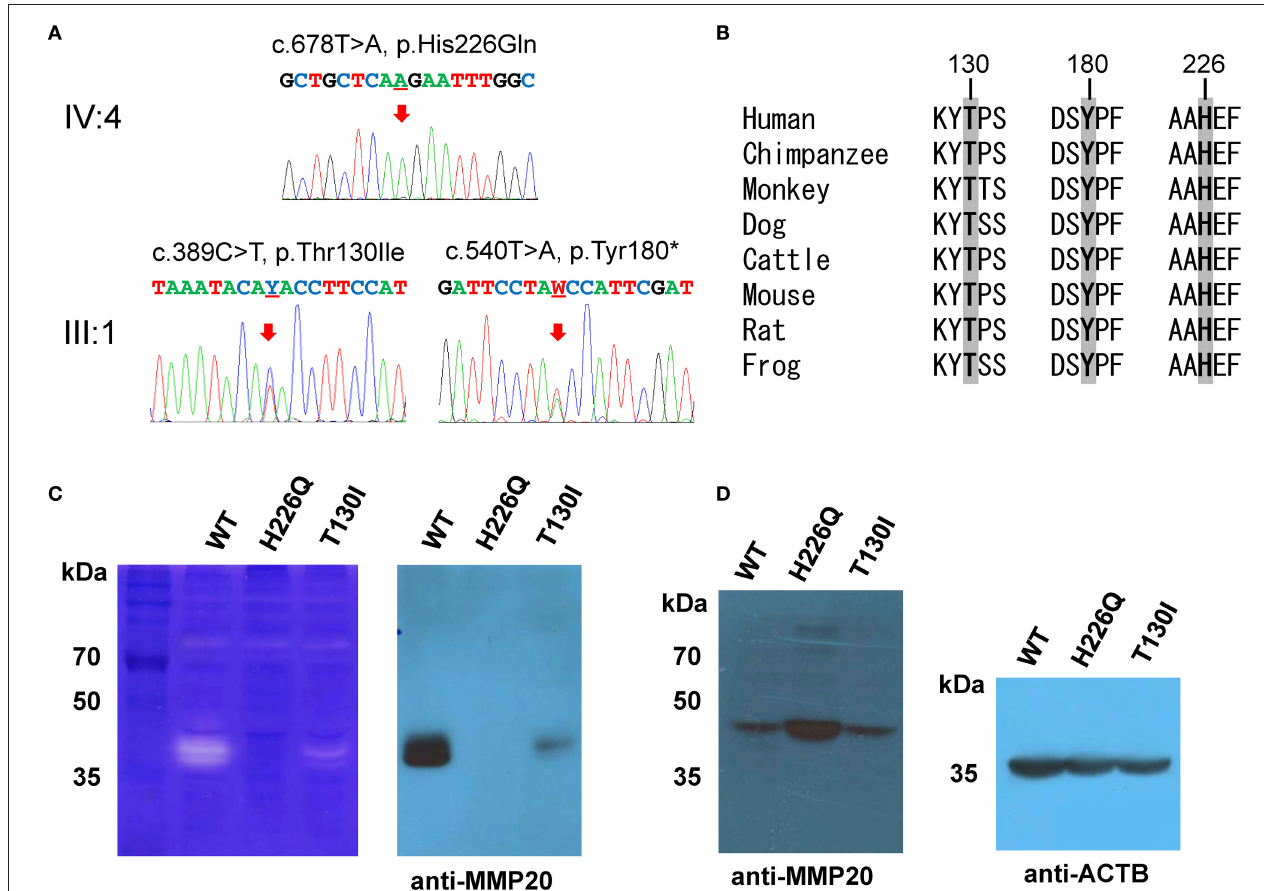
FIGURE 3 | Orthologs alignment, sequencing chromatograms and in vitro translation. (A) Sanger sequencing chromatograms of the probands (IV:4 of family 1 and III:1 of family 2). The mutated nucleotide is indicated by a red arrow and underlined (Y; C or T and W; A or T). (B) Sequence alignment of vertebrate orthologs. Amino acids affected by the mutations are indicated with bold character and gray highlight. Numbers above the amino acids are based on the human MMP20 sequence. (C) Casein zymography indicated that the p.Thr130Ile mutant protein retains proteolytic function, but the p.His226Gln mutant protein has no proteolytic activity. Western blot of the conditioned media revealed that the secretion of the p.Thr130Ile mutant protein into the culture media was greatly reduced, but the p.His226Gln mutant protein cannot be secreted at all. (D) Western blot of the cell lysate demonstrated that the p.His226Gln mutant protein remained in the cell. (ACTB: beta actin).